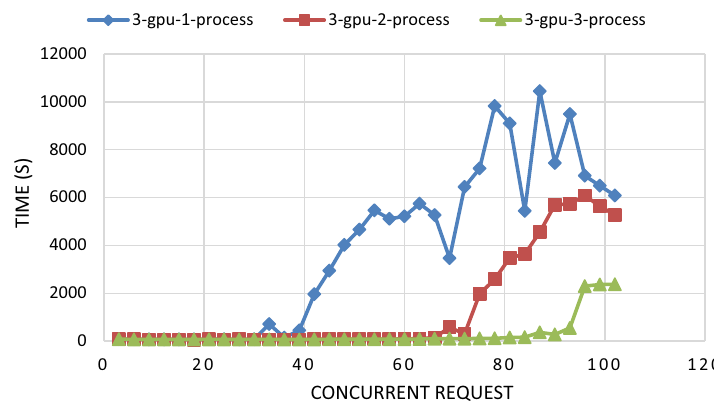
Fig. 10 Execution time (seconds) based on the concurrent request for 3